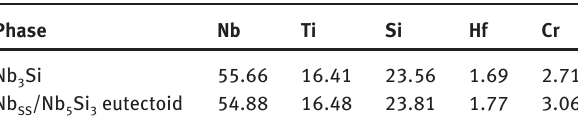
Table 1: Composition of the Nb SS /Nb 5 Si 3 eutectoid and Nb 3 Si determined by EDS.